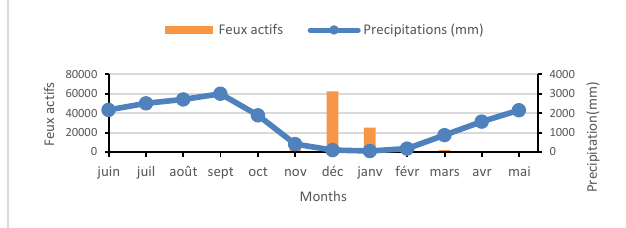
Figure 10: Interrelation between rainfall and number of active fires